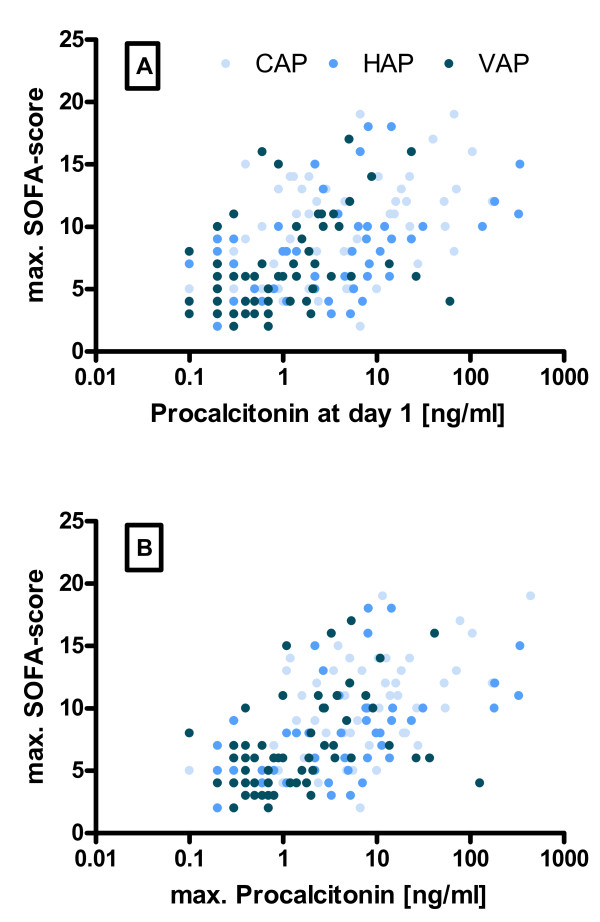
Correlation of initial or maximum PCT with maximum SOFA-score. Scatter plots representing the initial PCT (panel A) and the maximum PCT (panel B) vs. maximum SOFA score over the two weeks following inclusion. Square of correlation coefficients were r2 = 0.50 (95% CI: 0.38 to -0.61) for initial PCT and r2 = 0.57 (95% CI 0.46 to 0.66) for maximum PCT.